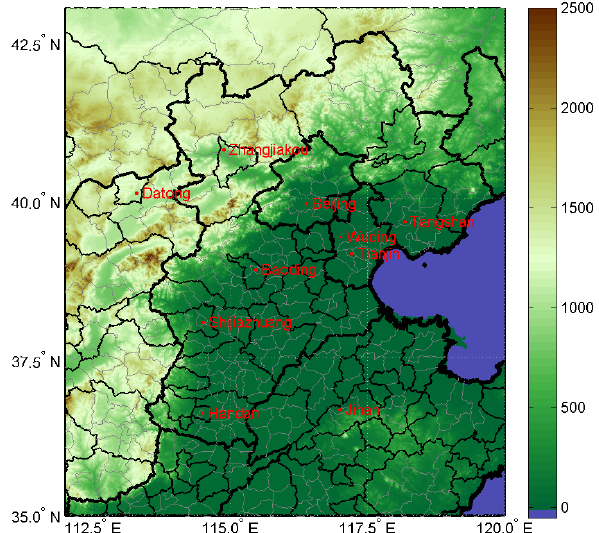
Figure 1 the Map for the Measurement Site 5 The color represents the elevation with data from Jarvis et al. (2008). The main cities in this area are marked in 6 Fig. 1. Map for the measurement site. The color represents the the map. 7 elevation with data from Jarvis et al. (2008). The main cities in this 8 area are marked in the